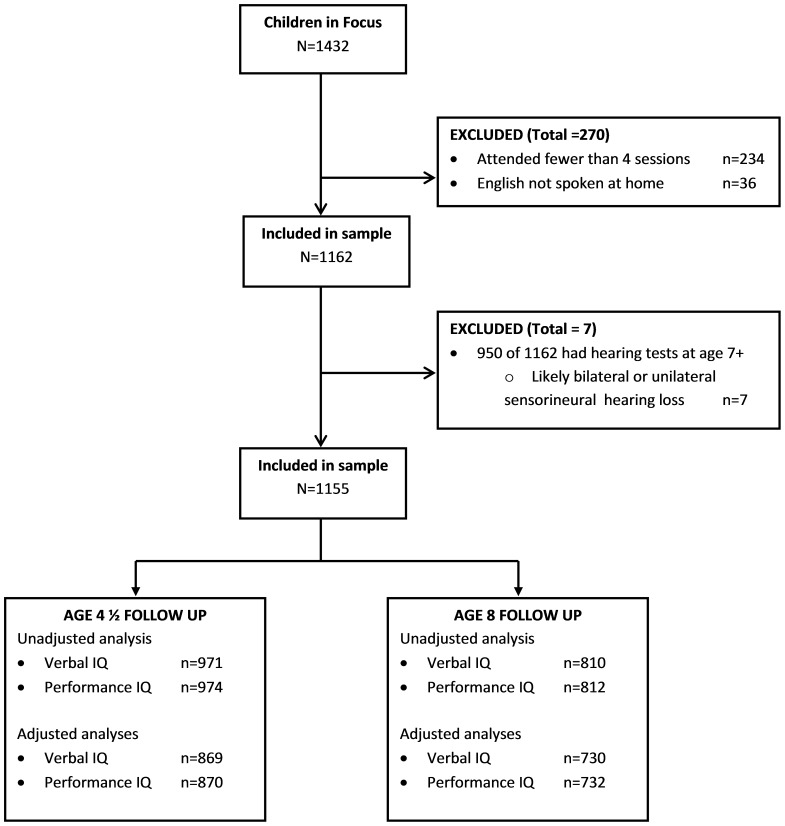
Participant flow diagram.Variables included in adjusted analyses were maternal education level, housing tenure, parental social class, maternal age, parity, smoking during 1st three months of pregnancy, smoking in last two weeks of pregnancy, birthweight, gestational age, sex of child.